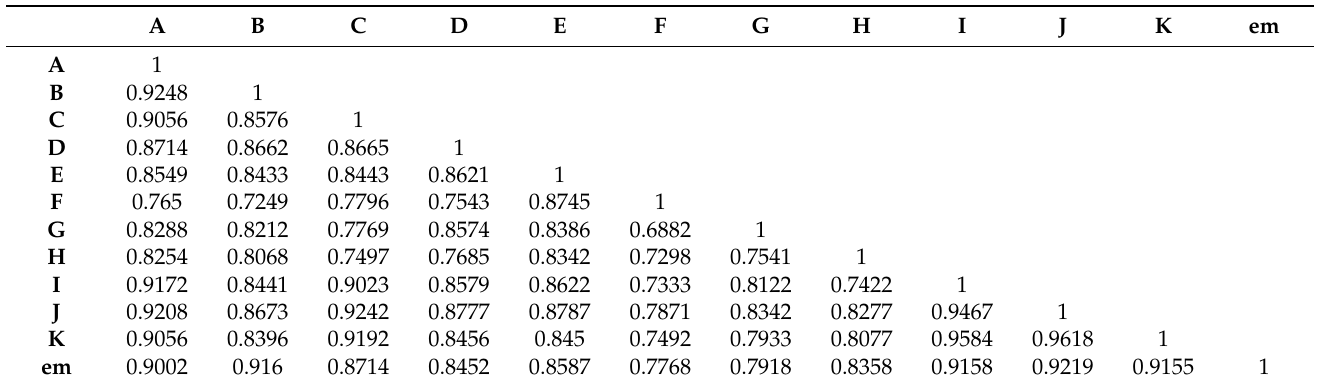
Table A1. Whole-year temporal correlation of PM2.5 between monitoring stations.